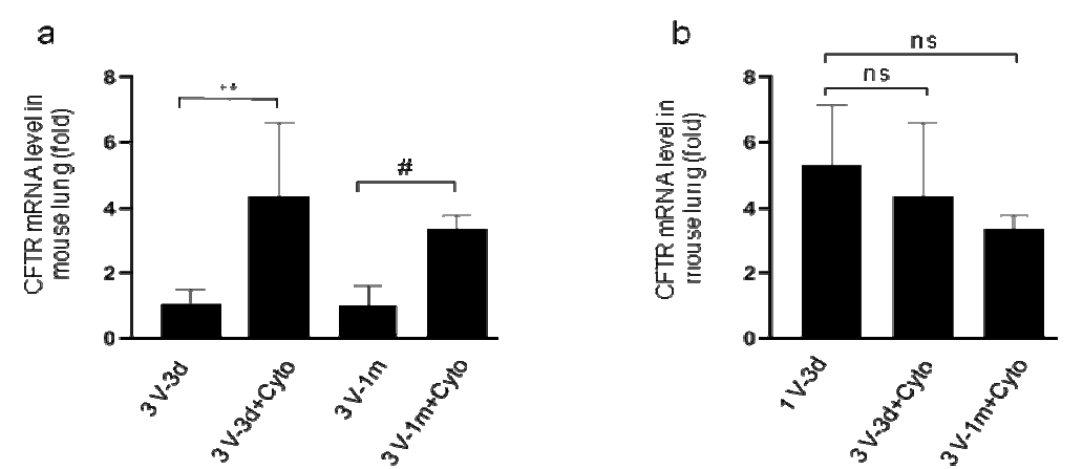
Figure 5. Expression of human cystic fibrosis transmembrane conductance regulator (CFTR) mRNA in mouse lungs assessed by real-time RT-qPCR. ( a ) CFTR mRNA levels in lung tissues of mice at days 3 and 33 following the last round of HD-Ad- CFTR delivery with or without cyclophosphamide treatments. The transgene expression was normalized with 18S. Data were presented as mean ± SD. n = 5; #: p < 0.05; **: p < 0.01. ( b ) CFTR mRNA levels in mouselung tissues from 3 days of single dose delivery (1V-3d), and at days 3 (3V-3d) and 33 (3V-33d) of 3 dose delivery following the last round of transduction with cyclophosphamide treatment. Data were presented as mean ± SD. Ns indicates no significant difference.